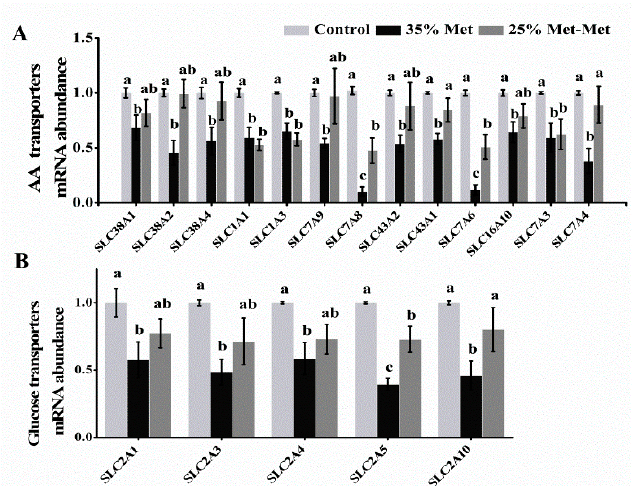
Figure 6. The AA transporters mRNA abundance ( A ) and glucose transporters ( B ) in the placenta at day 17 with different sources of methionine (Met) supplementation. The control group (Control) was fed a diet supplemented with Met, and the 35% Met group was fed a Met-restricted diet and received intraperitoneally injections with 35% of the Met in the control diet. The 25% Met-Met group was treated as the 35% Met group, with 25% of the Met replaced with methionyl-methionine (Met-Met). The data are expressed as the mean ± SEM; three placentas were selected randomly from each group, n = 3. The experiment was repeated three times. The different letters indicate significant differences, p < 0.05.